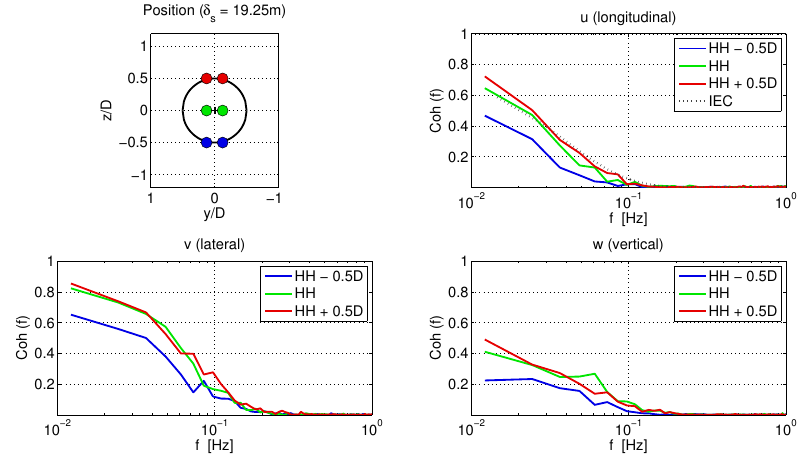
Figure 6. Coherence functions for the three free-stream turbulence components with the same lateral separation (19.25 m) at different